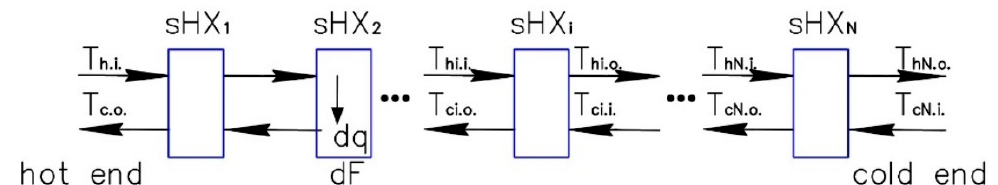
Figure 5. Scheme of regenerator split.